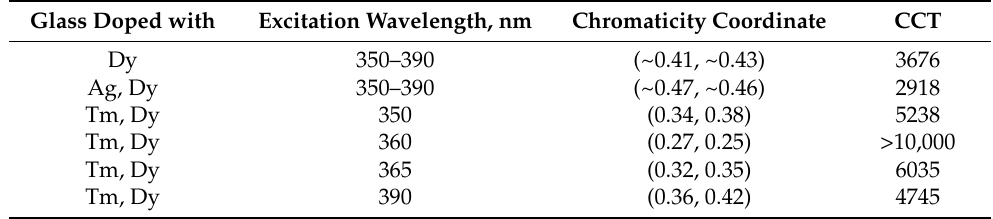
Table 1. The chromaticity coordinates and correlated color temperatures for the prepared glasses. Glass Doped with Excitation Wavelength, nm Chromaticity Coordinate CCT